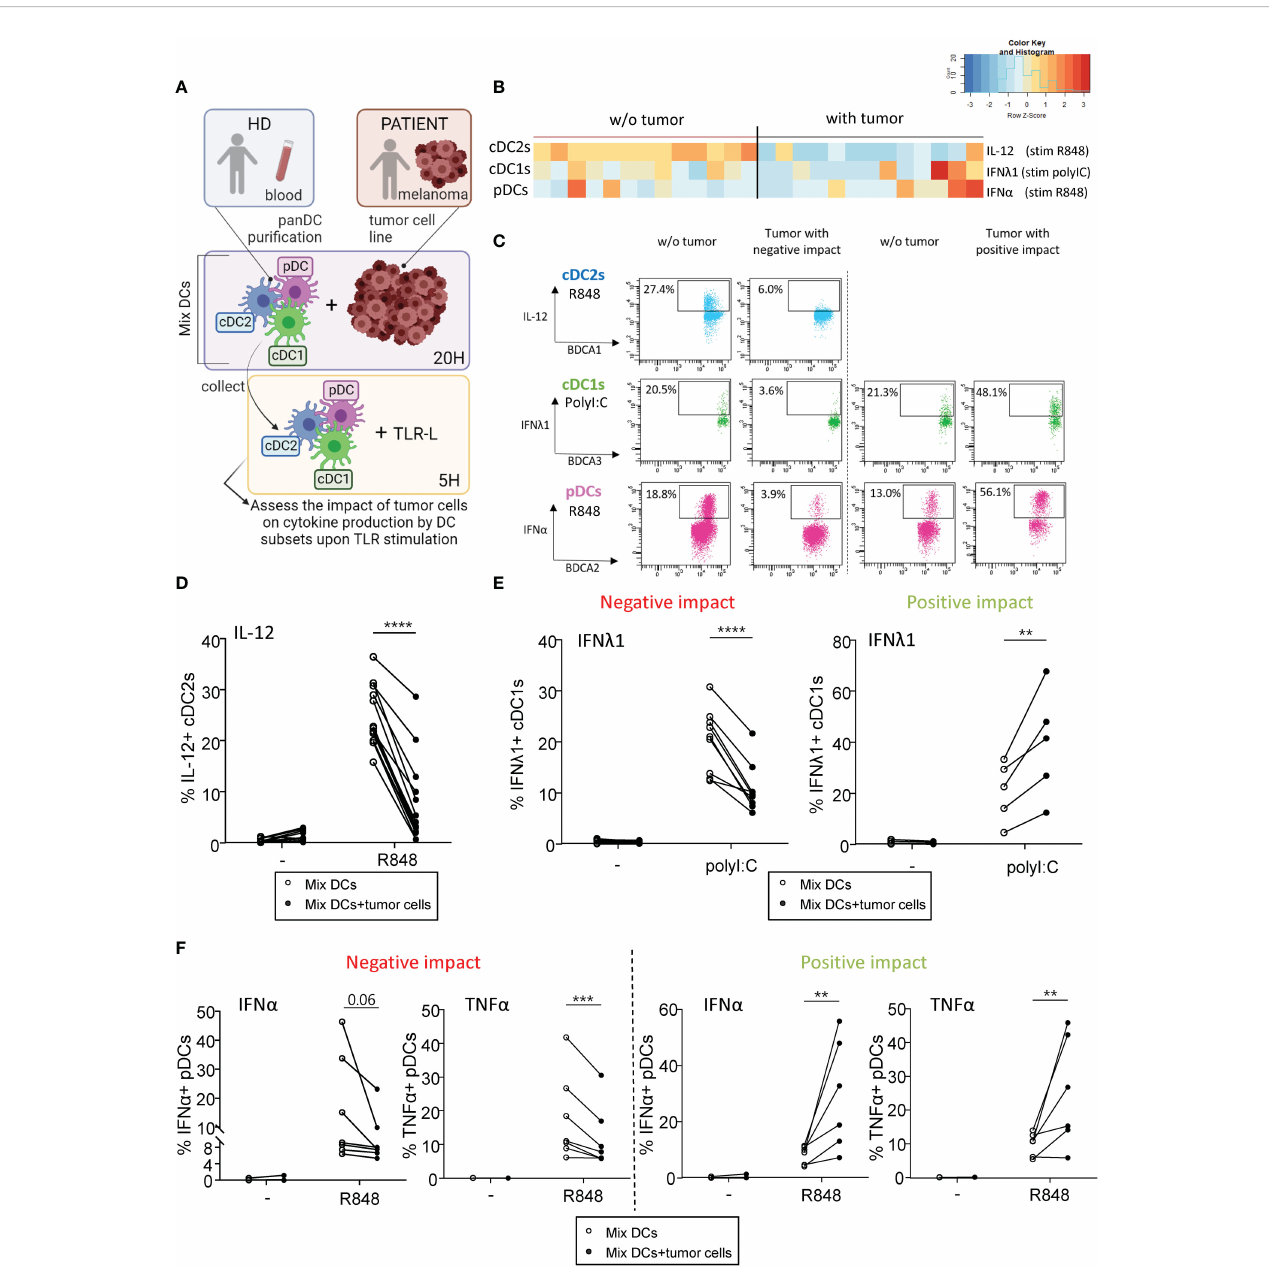
FIGURE 1 Primary tumor cell lines derived from melanoma patients differentially in fl uenced cytokine production by DC subsets upon TLR triggering PanDCs (mixture of the three DC subsets cDC2s, cDC1s, pDCs) were puri fi ed from several HD blood and co-cultured with distinct primary tumor cell lines (derived from melanoma patients) for 20 hours. Collected panDCs were stimulated for 5 hours with or without TLR-L (polyI:C or R848) and the production of cytokines was assessed by intracellular cytokine staining using fl ow cytometry. (A) Schematic representation of the experimental layout to investigate the impact of distinct tumor cell lines on cytokine production by healthy DC subsets. (B) Heat map based on cytokine production by cDC2s (IL-12p40/p70), cDC1s (IFN l 1) and pDCs (IFN a ) upon TLR stimulation after culture of PanDCs with distinct tumor cell lines (n = 13 tumors). Each tumor cell line was co-cultured with one to four PanDCs mixtures puri fi ed from different HD blood (n=13 donors) and mean percentages of cytokine + DCs were calculated and shown in the heat map. (C) Representative dot plots highlighting diverse impacts of co-culture of PanDCs with tumor cell lines derived from melanoma patients on cytokine production by DC subsets upon TLR stimulation (PolyI:C or R848) ( “ negative ” or “ positive ” impact). Dot plots are pre-gated on CD45 + Lin-HLA - DR + cells, in addition to CD11c + CD1c/BDCA1 + for cDC2s, CD11c + CD141/BDCA3 + for cDC1s, and CD11c - CD303/ BDCA2 + for pDCs as illustrated in Supplementary Figure 1. (D – F) Frequencies of cytokine-expressing cDC2s (D) , cDC1s (E) and pDCs (F) upon TLR triggering after co-culture with ( fi lled circles) or without (open circles) tumor cell lines derived from melanoma patients (n = 13 tumors). For cDC1s and pDCs, groups were separated depending of the “ negative ” or “ positive ” impact of the tumor on IFN l 1 or IFN a production respectively. Results are expressed as percentages of cytokine-expressing cells within the corresponding DC subset. Each point represents a different tumor cell line and illustrates the mean of co-cultures experiments of each cell line with one to four different HDs (n=34 PanDCs/tumor co-cultures in total). Only signi fi cant statistics are shown on graphs. P -values were calculated using matched two-way repeated measures ANOVA with Bonferroni ’ s multiple comparisons test. **P-value ≤ 0.01, ***P-value ≤ 0.001, ****P-value ≤